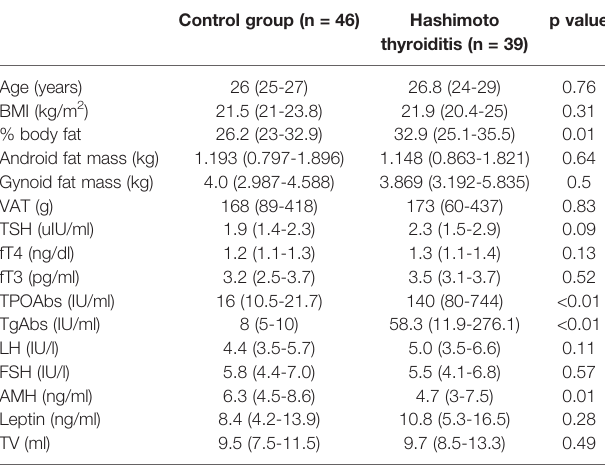
TABLE 1 | Clinical and biochemical characteristics of the studied groups. Control group (n =